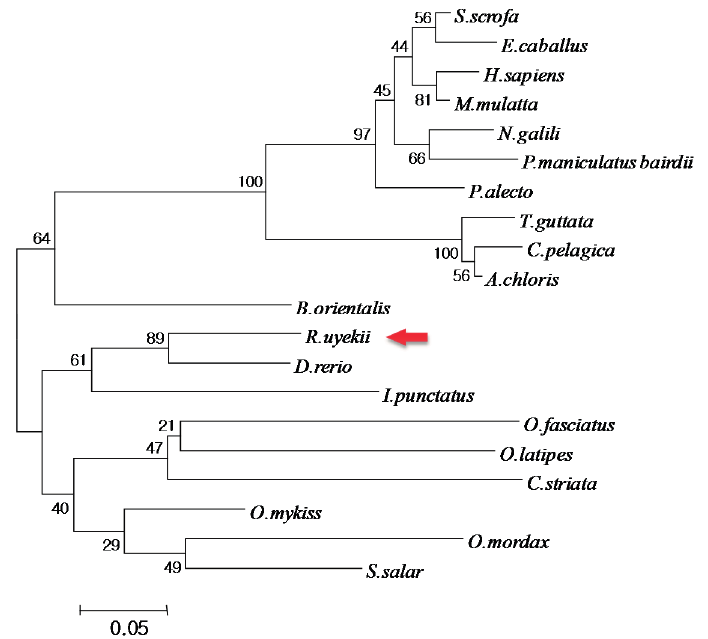
Figure 3. Phylogenetic analysis of the Korean rose bitterling RuTrx and related